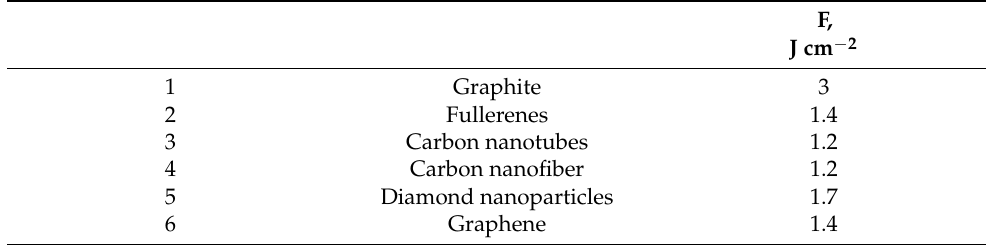
Table 1. Summary of the optimal fluencies of heating pulses for each of studies carbon-containing